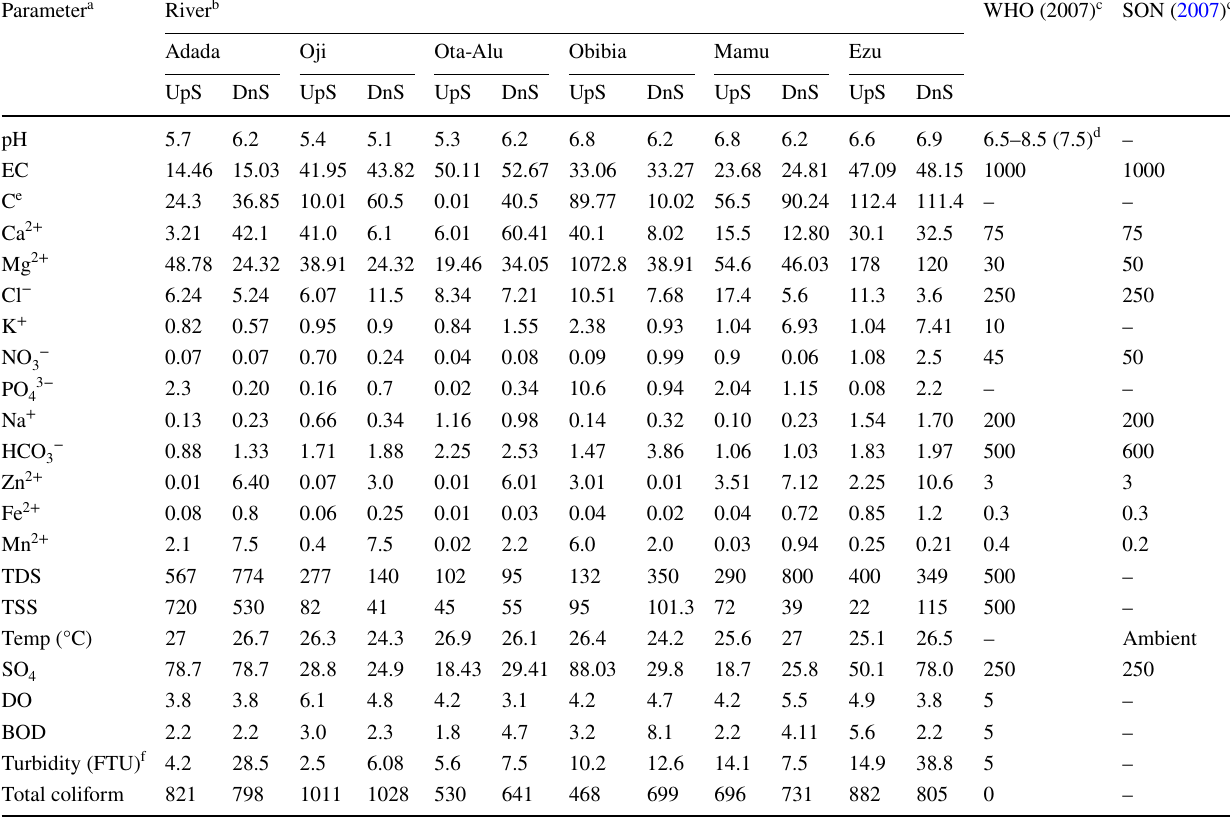
Table 6 Dry season’s hydrochemistry of surface water from Mamu River basin